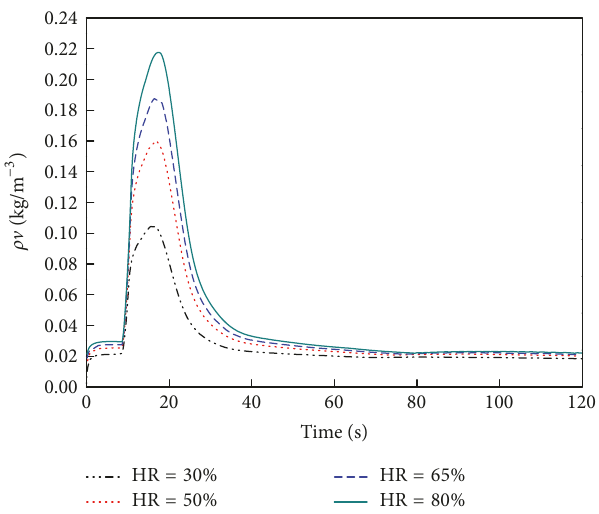
Figure 11: Profiles of water vapor density versus time at a distance of 0.56 × 10 −3